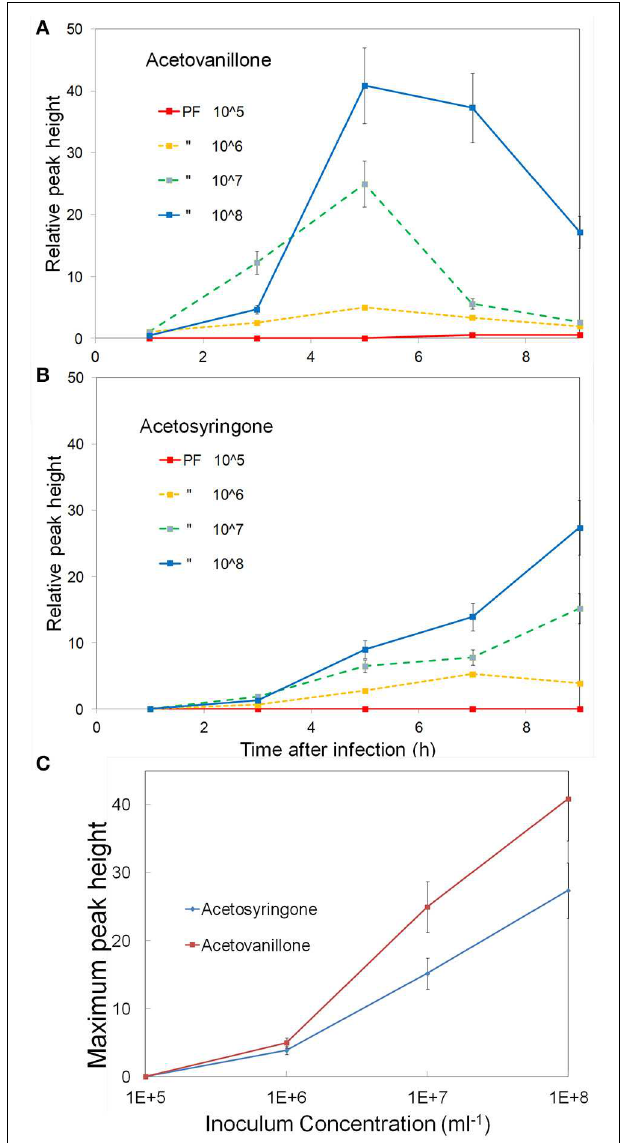
FIGURE 3 | Effect of inoculum concentration on the induction of apoplastic phenolics. Tobacco leaf segments were inoculated with varying figure. The relative concentrations of two phenolics are shown over a 9h period, (A) Acetovanillone and (B) Acetosyringone. (C) The peak concentrations of these metabolites vs. the log of inoculum concentration is shown. See Materials and Methods for further details.